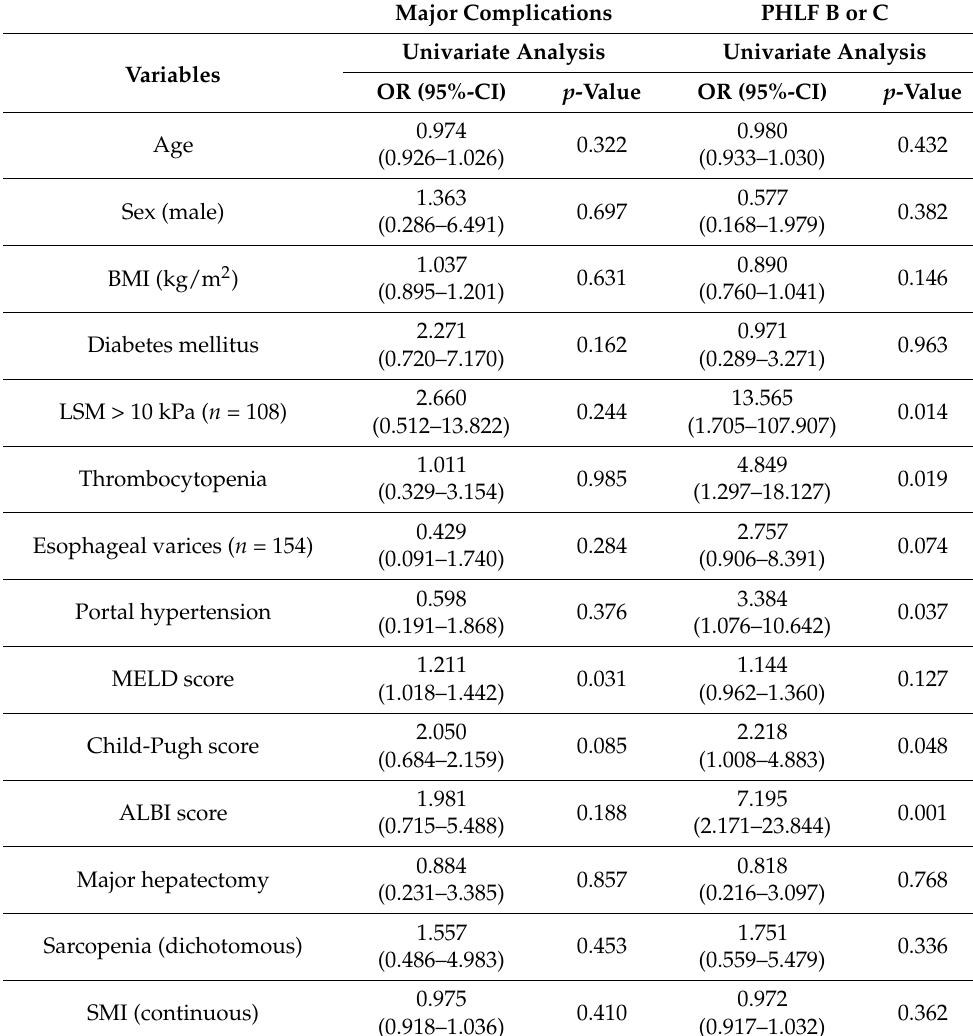
Table 3. Factors associated with the development of major complications and PHLF B or C after hepatic resection for